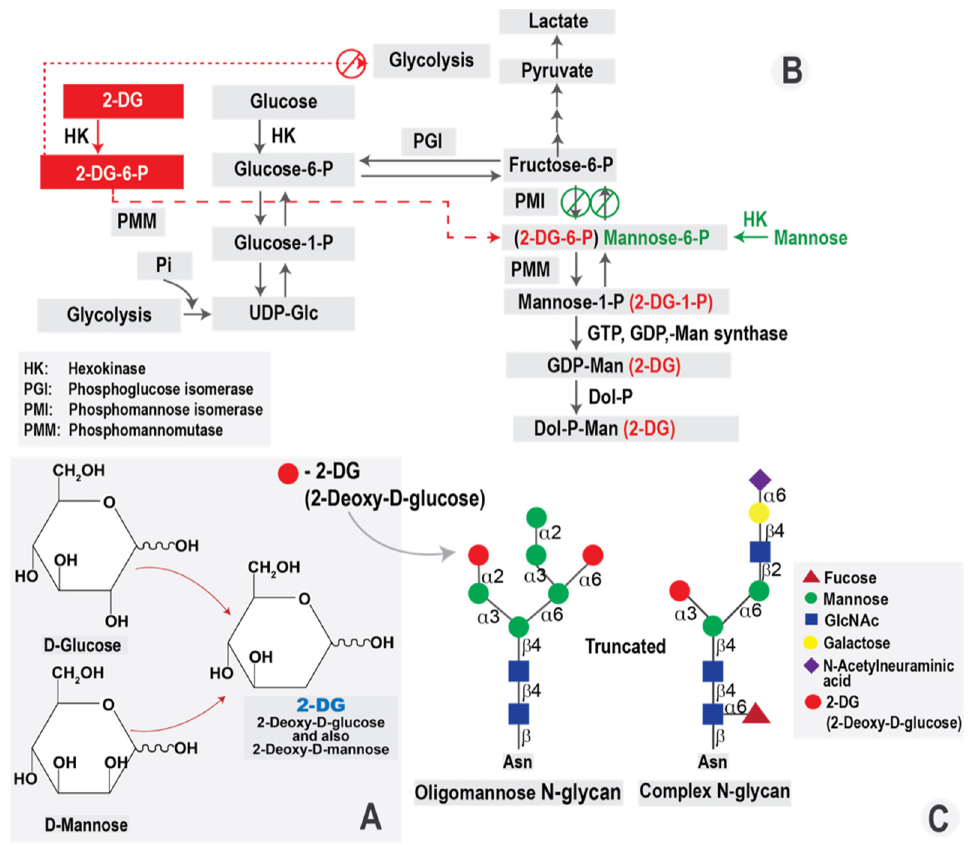
Figure 1. 2-Deoxy-D-glucose (2-DG) and its biological effects. ( A ). Structures of D-Glucose, D- Mannose and 2-DG; ( B ). The effects of 2-DG on the glycolysis pathway and substitution for mannose in N-glycan synthesis; ( C ). Truncation of N-glycosylation by 2-DG.